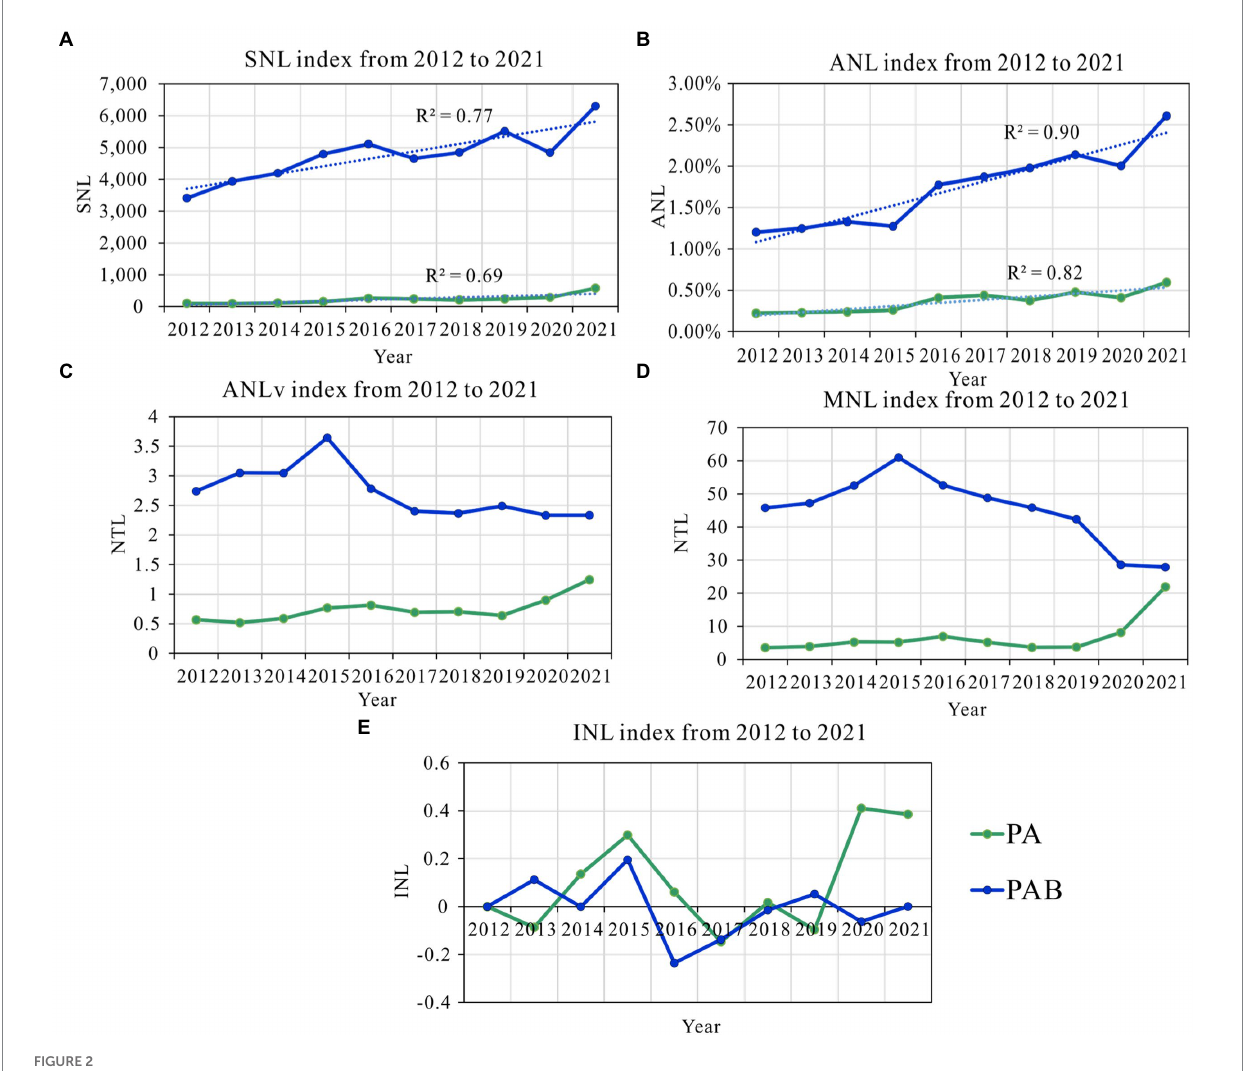
FIGURE 2 Annual change of nighttime lighting index in nature reserves and nature reserve buffer